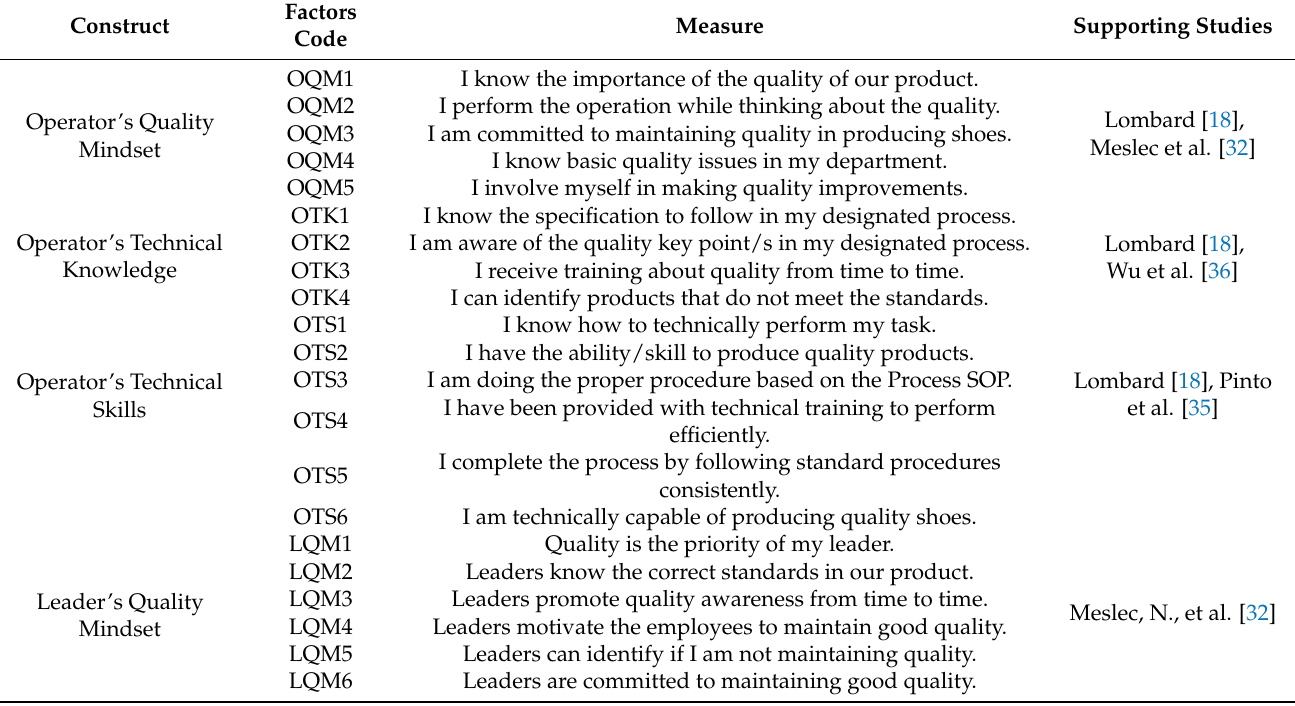
Table A1. The constructs and measurement